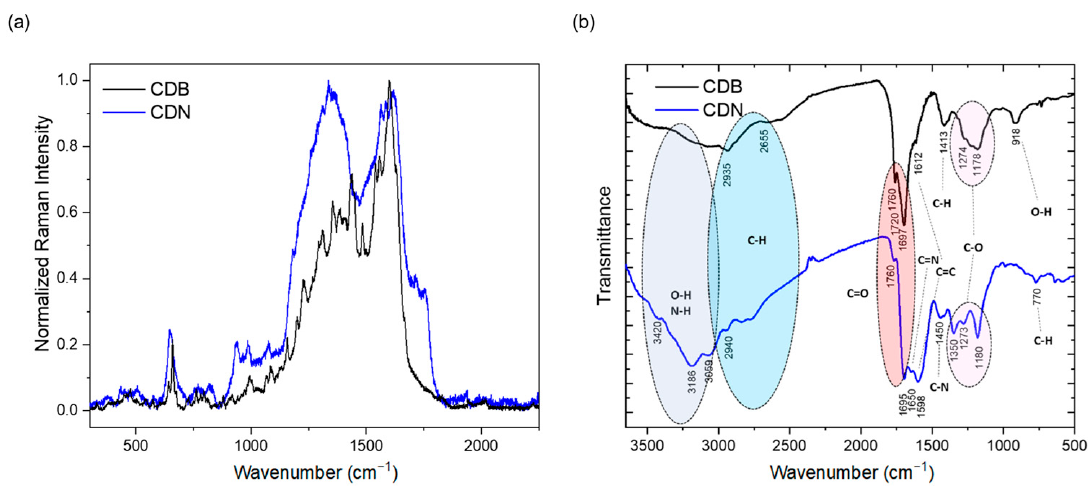
Figure 2. SERS ( a ) and FTIR ( b ) spectra of CDB and CDN samples.